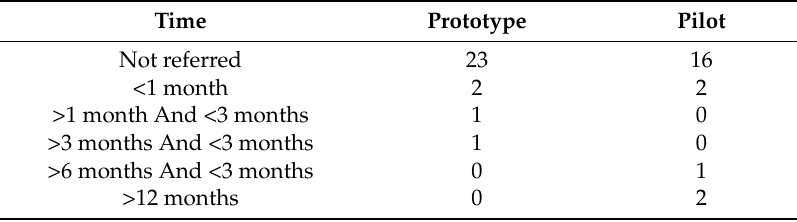
Table 4. Duration of prototypes and